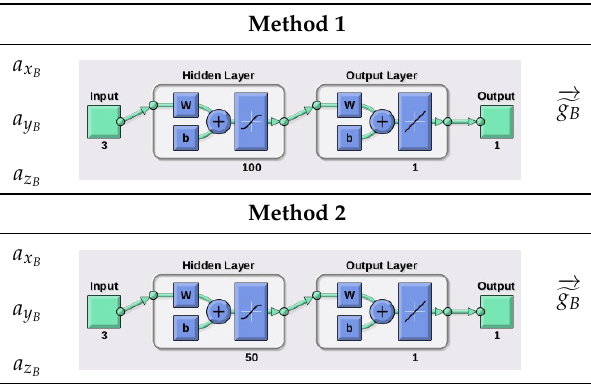
Table 2. Neural network schemes for the two different methods or strategies.